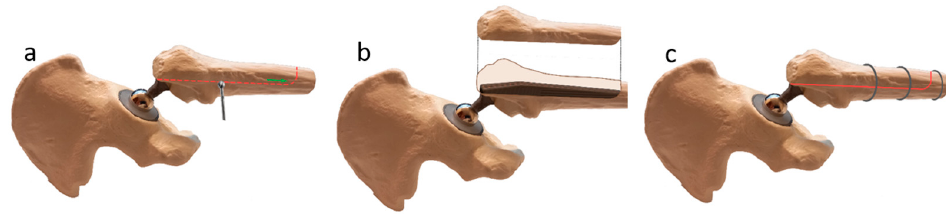
Figure 1. The ETO as described by Younger et al. [17]. ( a ). The posterior and distal part of the osteotomy border is outlined with several drill holes. The osteotomy is performed by connecting the holes with the saw or pencil bur. A cerclage is placed distal to the osteotomy to prevent a femoral fracture. The anterior part of the osteotomy is performed separately with the oscillating saw. ( b ). The osteotomy fragment is mobilized anteriorly with the osteotome. The stem is exposed. ( c ). After changing the stem, the osteotomized trochanter fragment is reduced and fixed with 2 to 3, 2.0 mm cerclage wires or